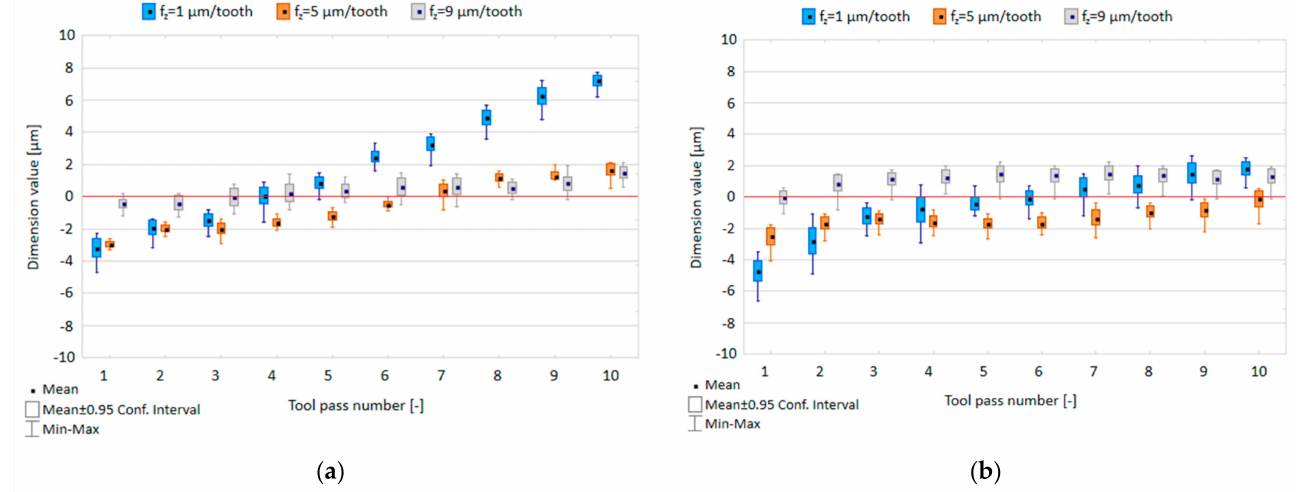
Figure 5. Feed per tooth f z versus dimensional accuracy in the milling process conducted using a tool coated with: ( a ) TiB 2 and ( b ) TiAlN; (v c = 800 m/min; a p = 80 µ m).